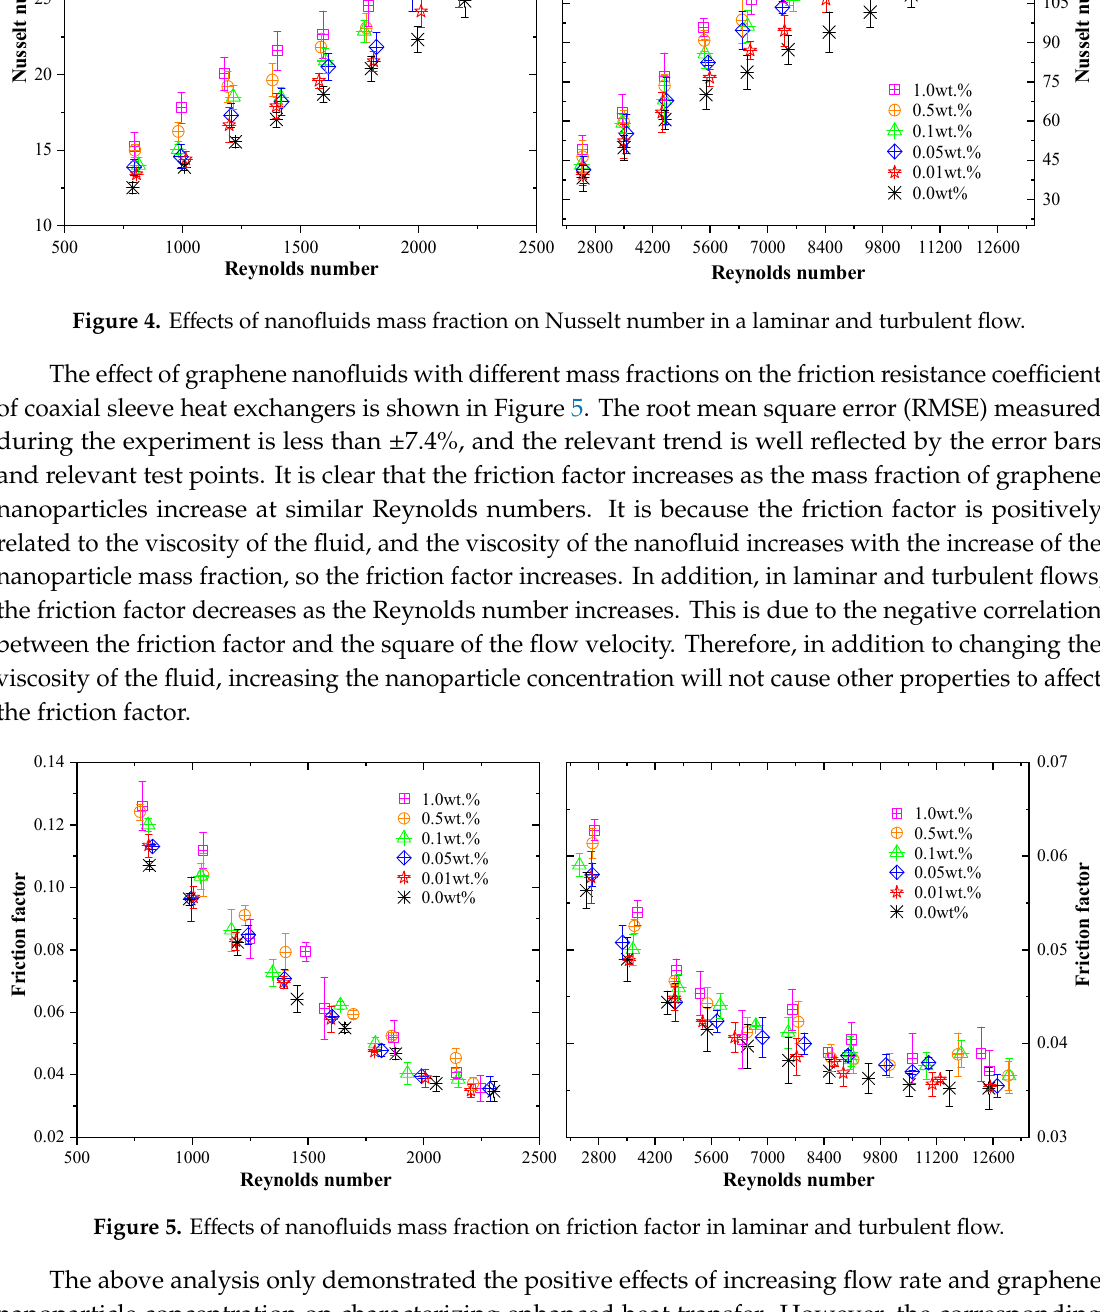
Figure 6. Pump power versus thermal efficiency of heat exchanger. The above analysis only demonstrated the positive effects of increasing flow rate and graphene nanoparticle concentration on characterizing enhanced heat transfer. However, the corresponding friction factor will also increase, and the energy efficiency evaluation of the heat exchanger is simply the result of strengthening the trade-off between the enhanced heat transfer and drag coefficient [40,41]. To further quantitatively analyze the effects of different graphene nanofluid concentrations and flow rates on the performance of heat exchangers, Figure 6 shows the relationship between the pump work and thermal efficiency of the heat exchanger. The results show that, under the experimental conditions, the heat transfer effectiveness of the six measured nanofluids in the heat exchanger gradually increases with the increase of the pump work. The increase in heat exchange performance of the heat exchanger is often accompanied by a pressure drop or pump power consumption, which is in line with the first law of thermodynamics. Secondly, due to the increase in